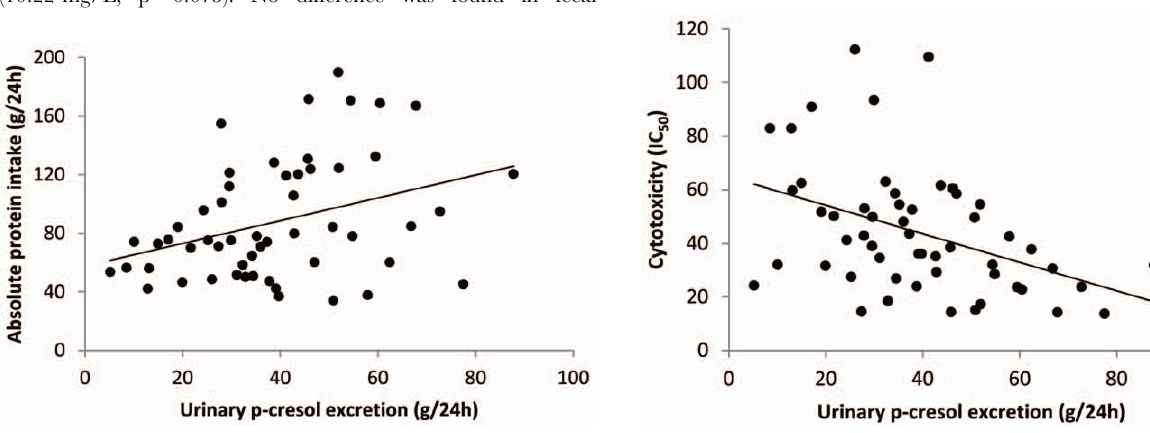
Figure 4. Scatter plot in which cytotoxicity (IC50) is plotted against urinary p-cresol excretion (mg/24 h). The plot shows a negative correlation between both parameters (Spearman’s r= 2 0.435,